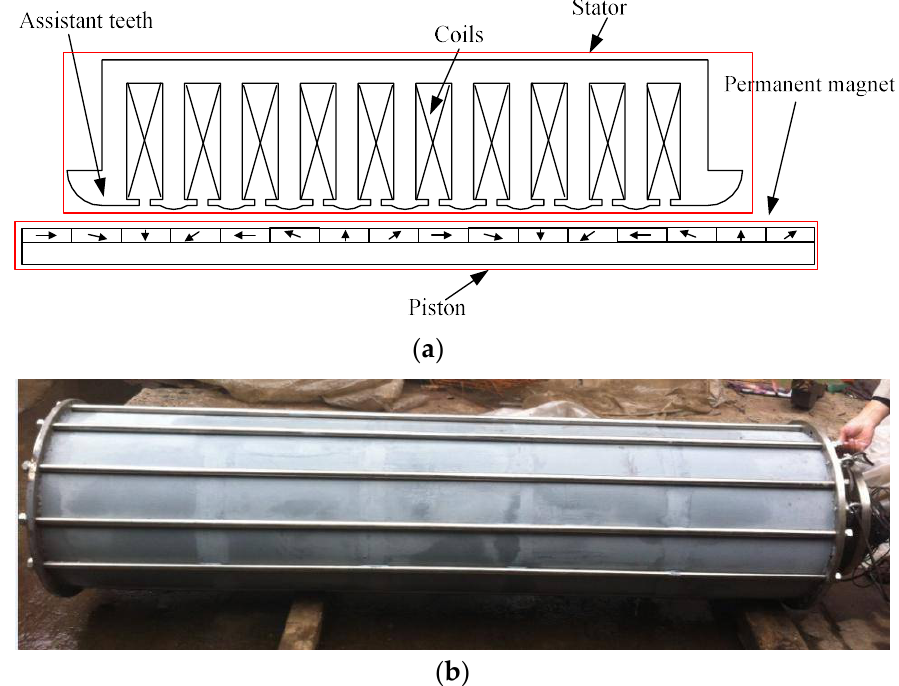
Figure 8. Halbach magnetized linear permanent magnet generator. ( a ) Sketch; ( b ) Prototype.